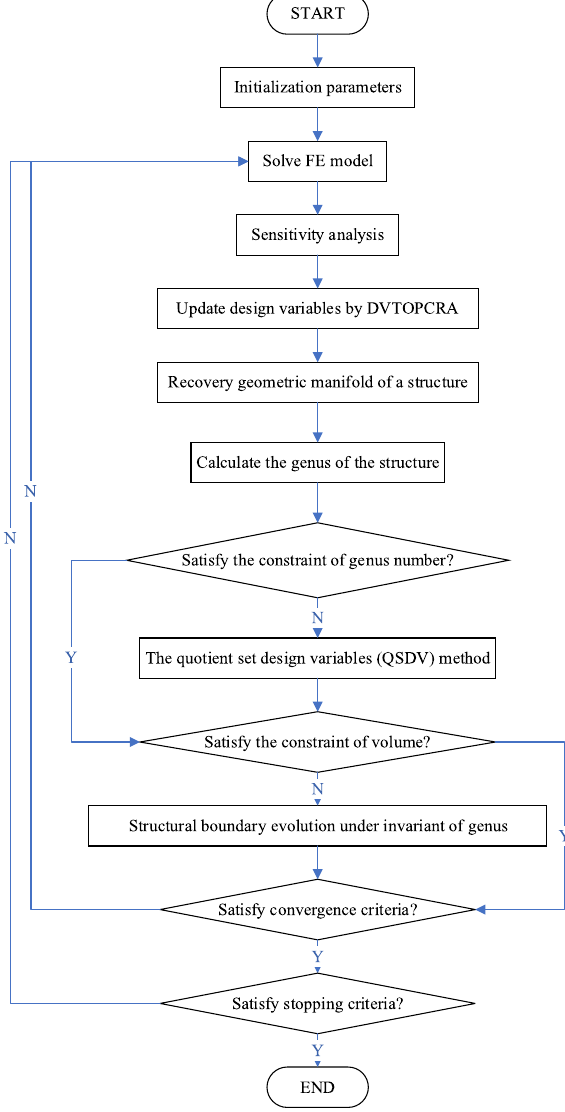
Figure 5. Program flow of the QSDV method based on